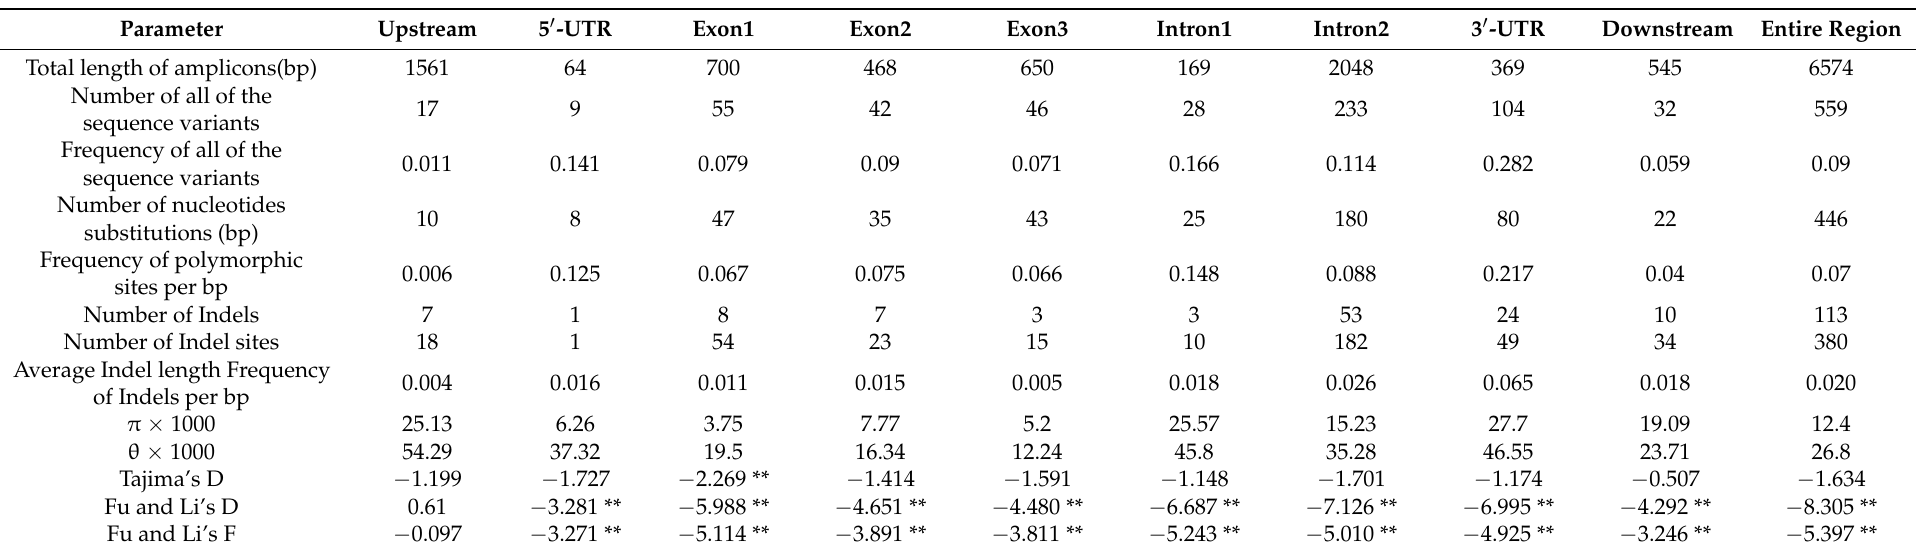
Table 1. Parameters for the sequence variants of